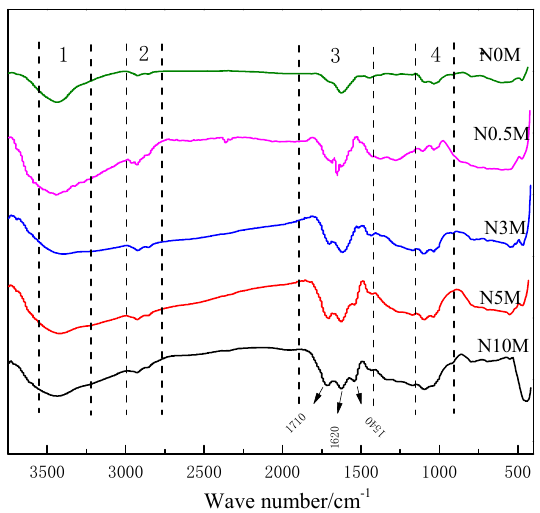
Figure 6. Fourier transform infrared spectra of lignite and nitric acid-modified lignite.